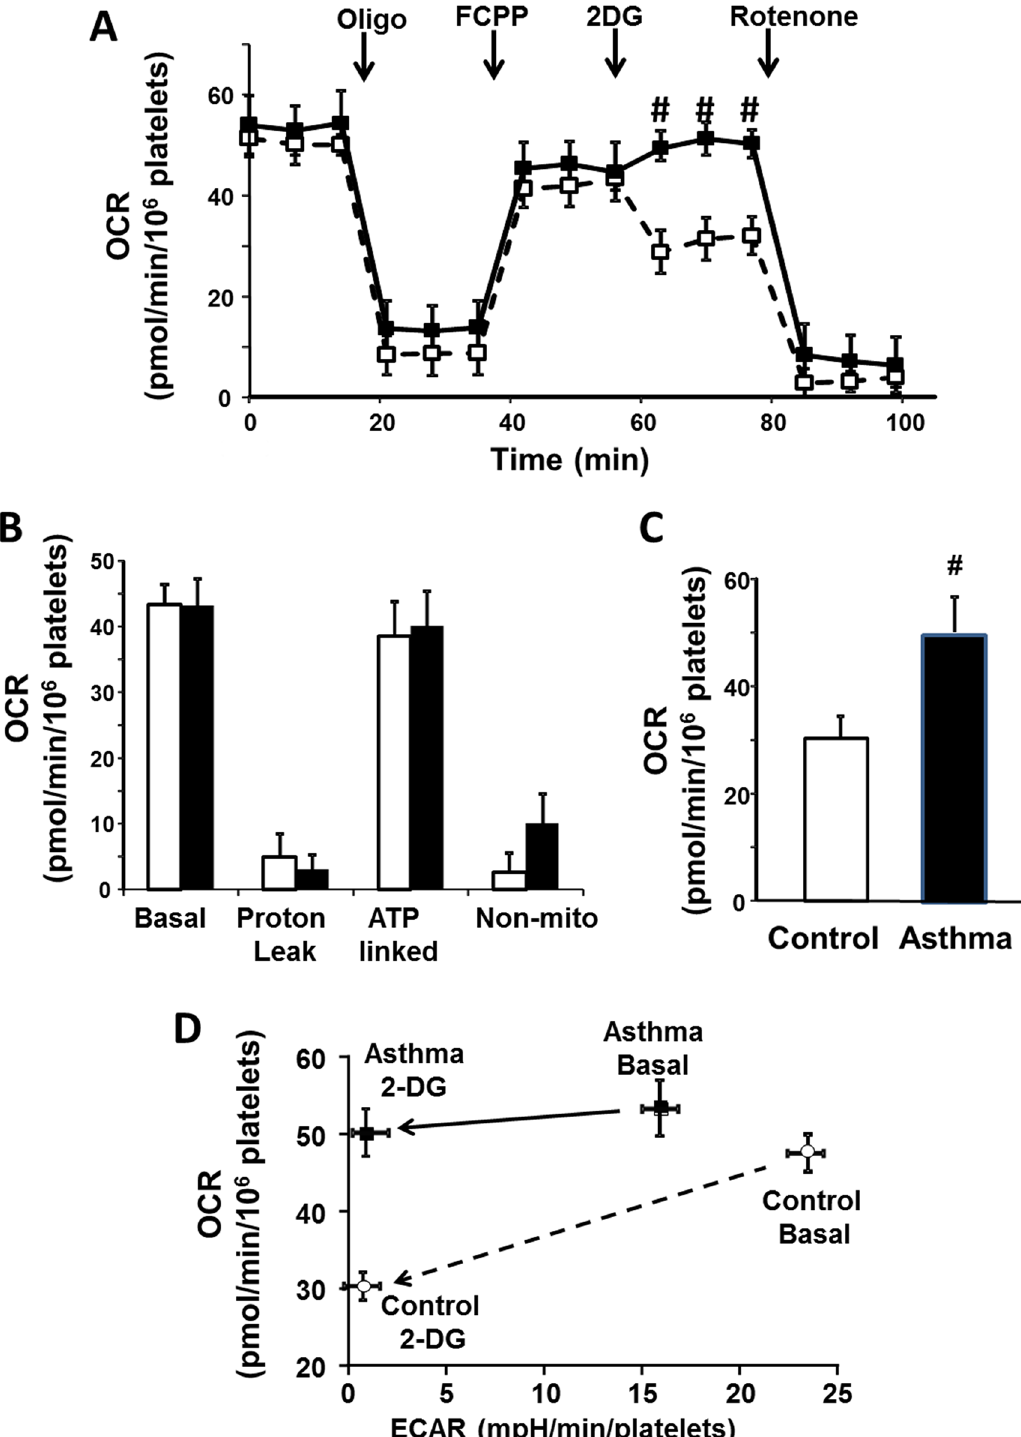
Fig 3. Platelets show less reliance on glycolysis in asthma. (A) Oxygen consumption trace for healthy (open squares) and asthmatic (filled squares). Basal rate is shown and arrows denote the addition of oligomycin A (oligo), FCCP, 2-deoxyglucose (2DG) and rotenone. (B) Quantification of basal rate, proton leak, ATP-linked respiration and non-mitochondrial oxygen consumption in platelets from healthy (open bars) and asthmatic (filled bars) subjects (calculated from traces such as those shown in panel A). (C) Quantification of oxygen consumption rate after the addition of 2-DG in healthy (open bars) and asthmatic (filled bars) platelets. (D) Changes in OCR as a function of ECAR in healthy (control; open circles) and asthmatic (Asthma; filled squares) platelets basally and after the addition of 2-DG. Arrows depict the shift after addition of 2-DG. Data are means ± SEM. #p < 0.05. n = 12 for asthma, n = 13 for control. doi:10.1371/journal.pone.0132007.g003 PLOS ONE | DOI:10.1371/journal.pone.0132007 July 6,